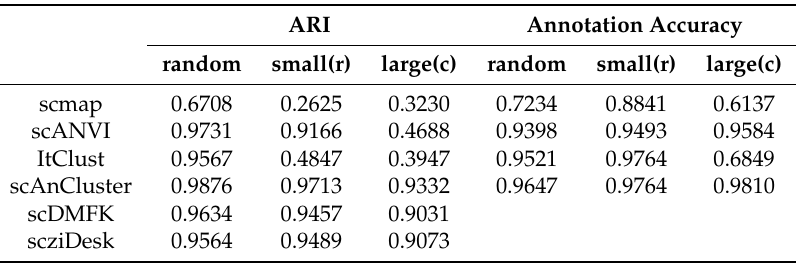
Table 4. Average performance of scmap, scANVI, ItClust, scAnCluster, scDMFK and scziDesk on the “Campbell” dataset. “random” refers to randomly selecting a certain percentage of cells to form a